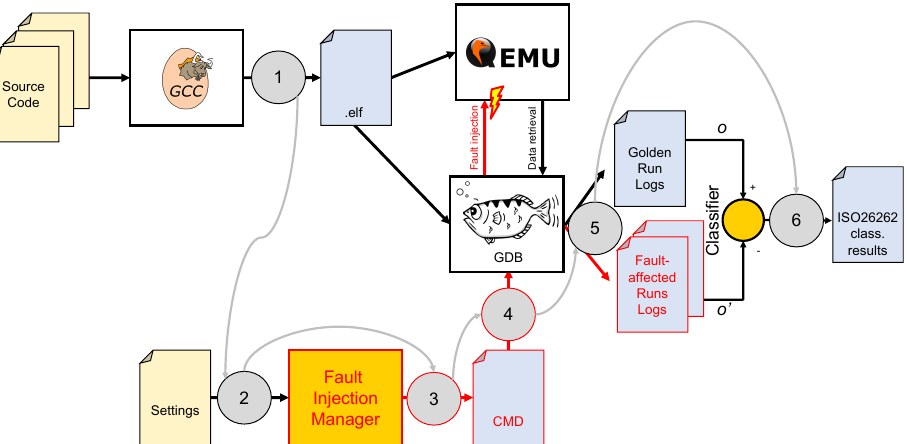
Figure 1. The proposed test bench architecture. GCC also compiles the classifier, of which the source code is generated by the FIM. The round numbered boxes and the gray arrows represent the functional flow of the